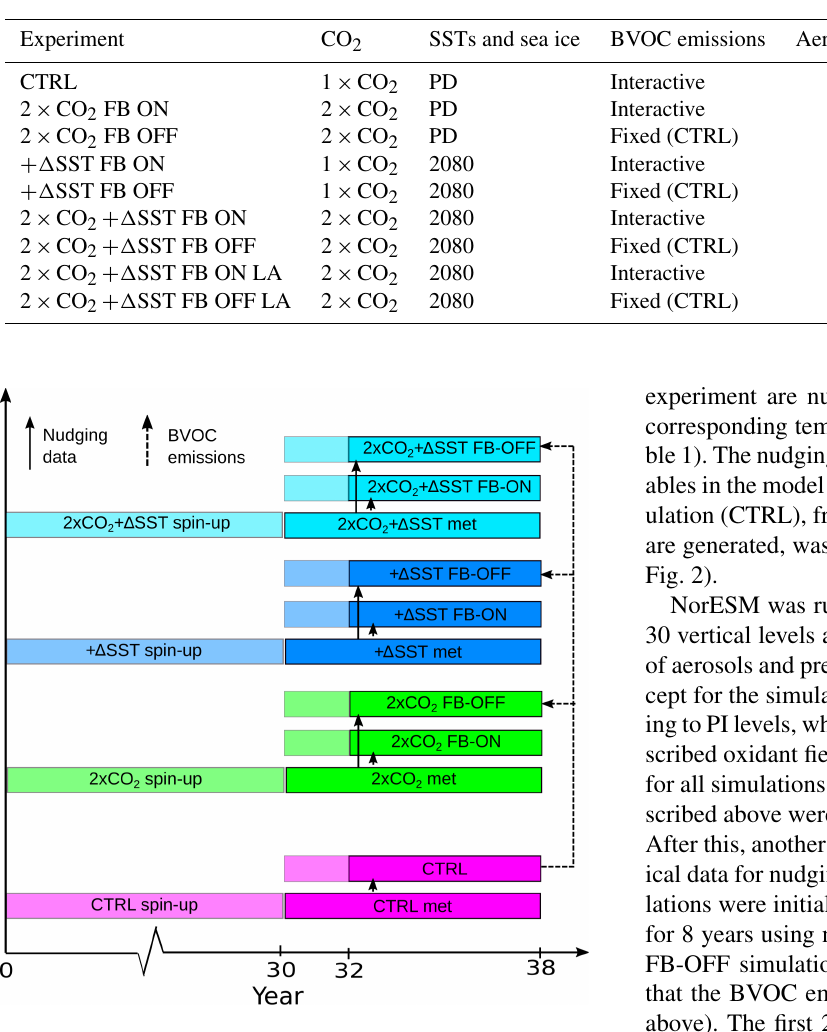
Figure 2. The simulation setup. The CTRL simulation has CO 2 and SSTs at present-day (PD) levels. The 2 × CO 2 simulations have dou- bled CO 2 with respect to the year 2000. In the + (cid:49) SST simulations, the SST and sea ice are increased to the year 2080 levels. In the 2 × CO 2 + (cid:49) SST simulation, the CO 2 is doubled and the SST and sea ice are changed to the year 2080 levels. The CTRL, as well as all FB-ON and FB-OFF simulations, is nudged to their respective met simulation. All FB-ON simulations have interactive emissions, while the FB-OFF simulations have fixed emissions from the CTRL